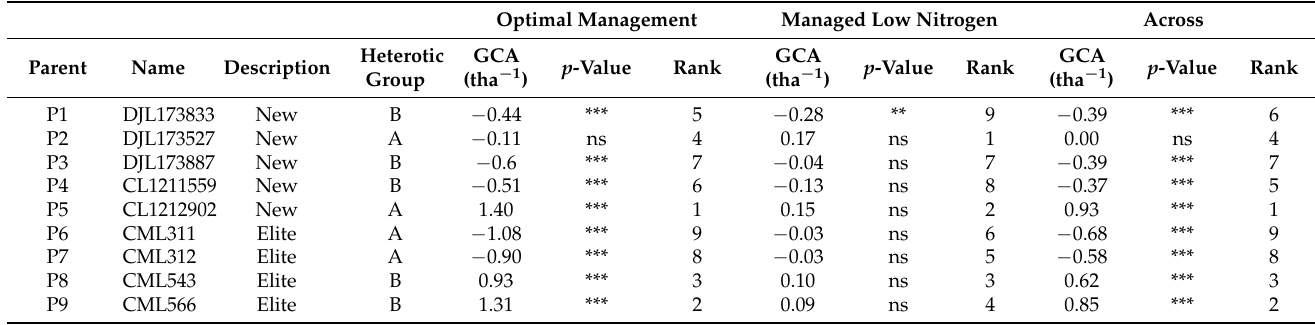
Table 4. The general combining ability (GCA) effects of new and elite CIMMYT lines evaluated under low-nitrogen and optimal conditions in Zimbabwe and Zambia during the 2018 and 2019 summer seasons.